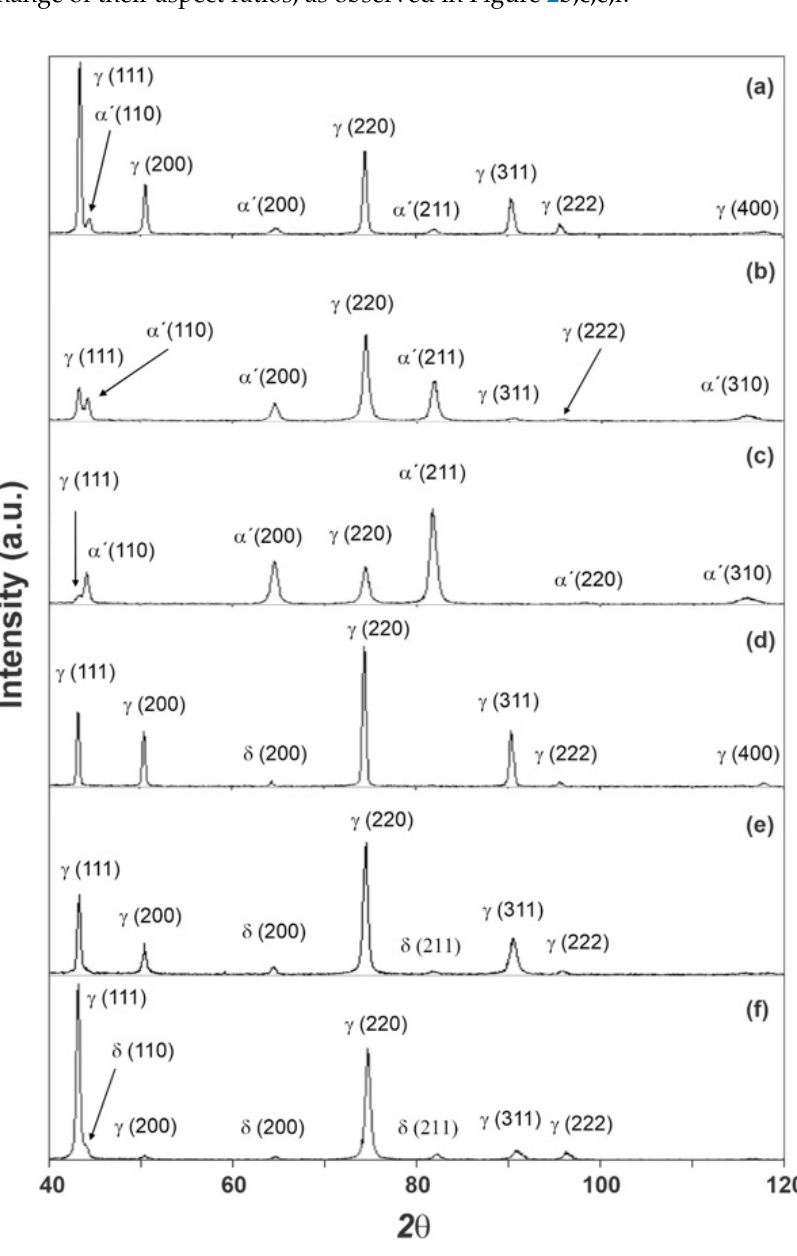
Figure 1. Diffractograms obtained for the A0 ( a ), A1 ( b ), A2 ( c ), B0 ( d ), B1 ( e ), and B2 ( f ) samples. Figure 3 corresponds to the initial condition of the AISI 301L steel, and the γ and α ’ phases can be seen; the optical microscopic analysis indicated that the distribution of